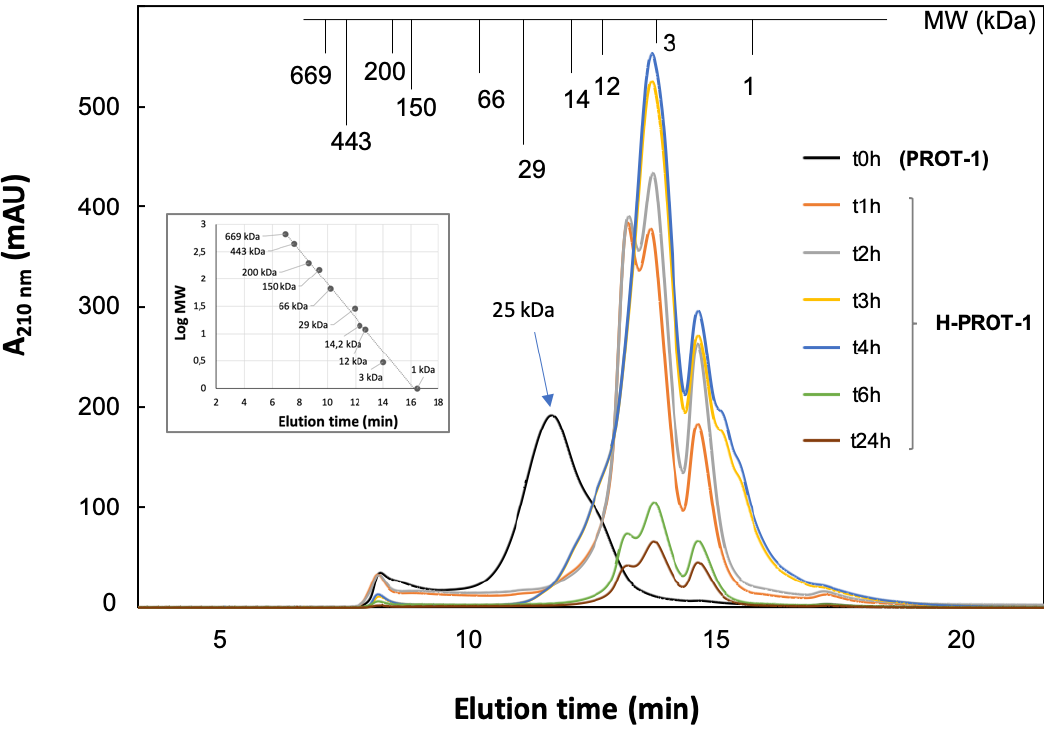
Figure 2. Standard curve and time-course HPLC-SEC profiles of PROT-1 enzymatic hydrolysis catalyzed by the protease preparation Flavourzyme ® .